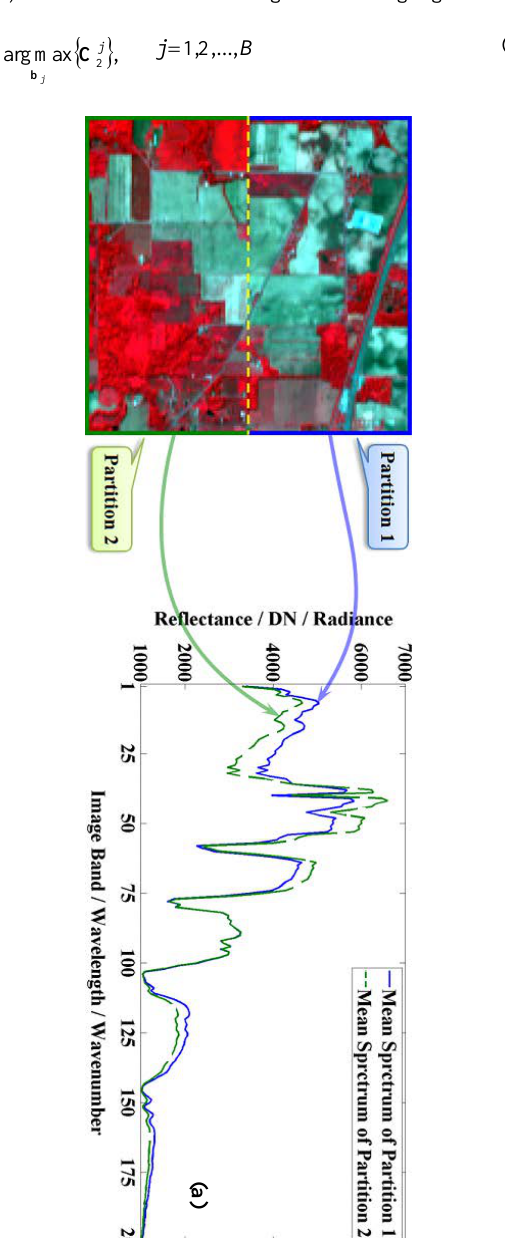
the jungle/agricultural region of Indian Pine in the Indiana state, USA, with a size of 145 × 145 pixels in 220 spectral bands and 0.4-2.5 range (https://engineering.purdue.edu/~biehl/MultiSpec/hyperspectral. html). The image is reported to contain 16 classes (Table 1). Bands 104~108, 150~163 and 220 are noisy and water absorption bands and were removed from the list of original bands to leave 200 bands (Chang,